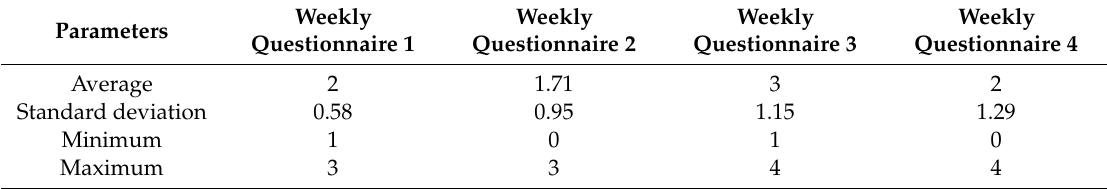
Table 1. Statistical analysis of the points obtained by teenagers with the different questionnaires. Weekly Weekly Weekly Parameters Questionnaire 1 Questionnaire 2 Questionnaire 3